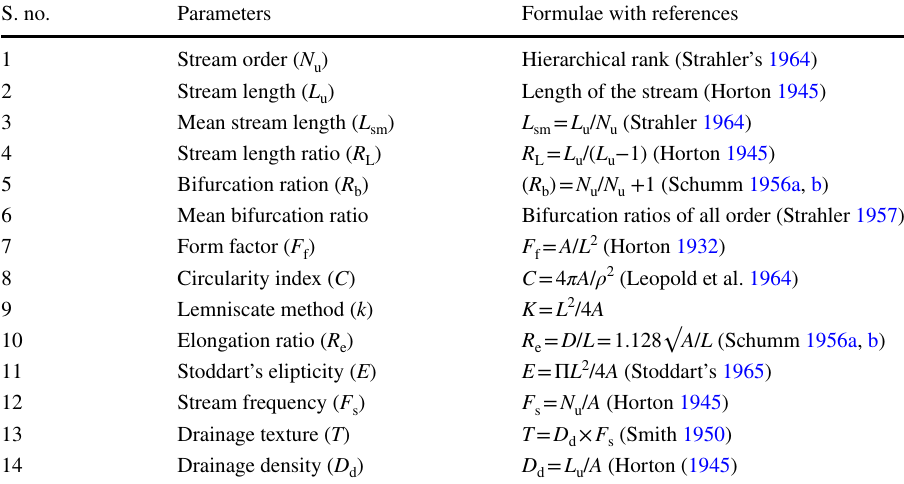
Table 1 Morphometric